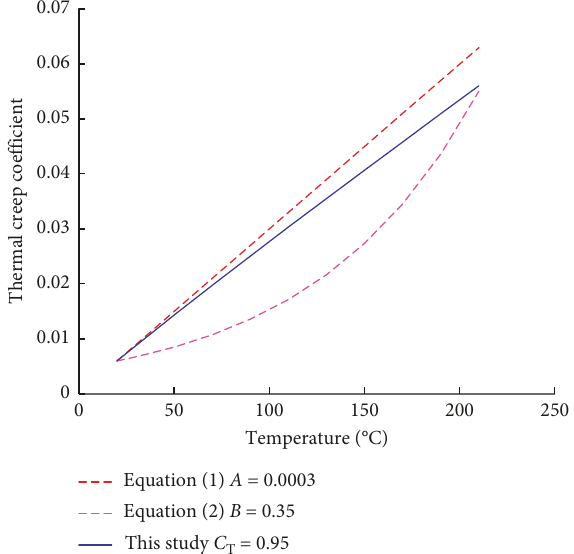
Figure 3: Comparisons of the equations describing the relationship between thermal creep coefficient and